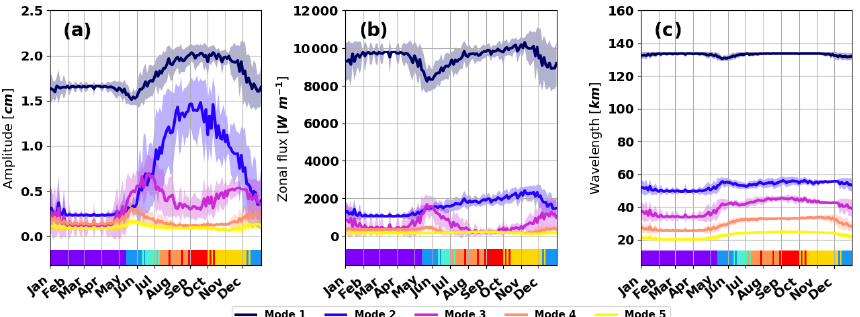
Figure 8. Weighted mean of (a) the surface elevation amplitude, (b) the vertically integrated zonal energy flux and (c) the surface wave- length for each vertical mode during the year. The calculations are based on the Bay of Biscay simulations over the abyssal domain ( − 300km <x < 200km). The climatology is built with a time step of 3d where the ratio of each cluster is used as the weight. The shading represents the weighted standard deviation. The ruler at the bottom of the plots shows the color of the dominant cluster along the